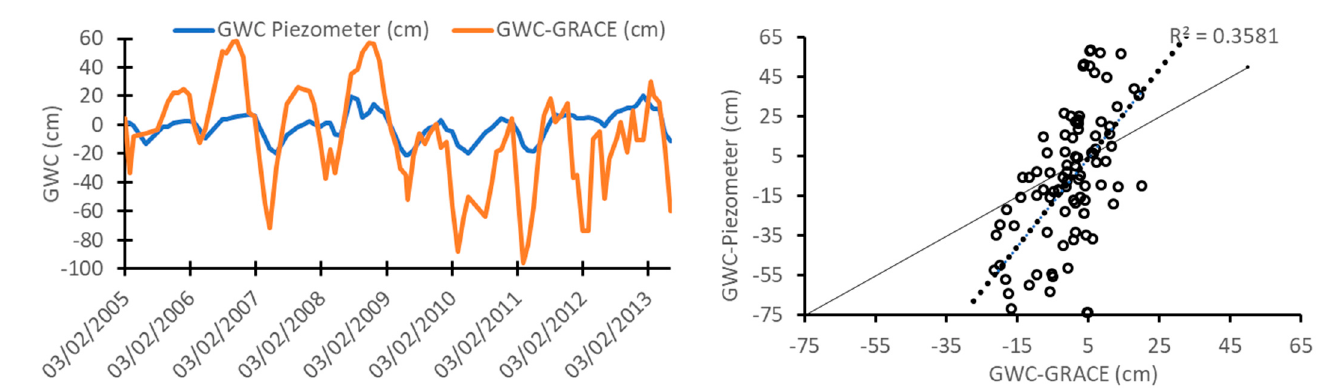
Figure 11. ( a ) Correlation of the observed (observation well data) and estimated (GRACE-based) groundwater storage anomalies in LBDC. ( b ) Correlation of the observed (piezometric data) and GRACE-based groundwater storage changes in the Kabul River Basin.